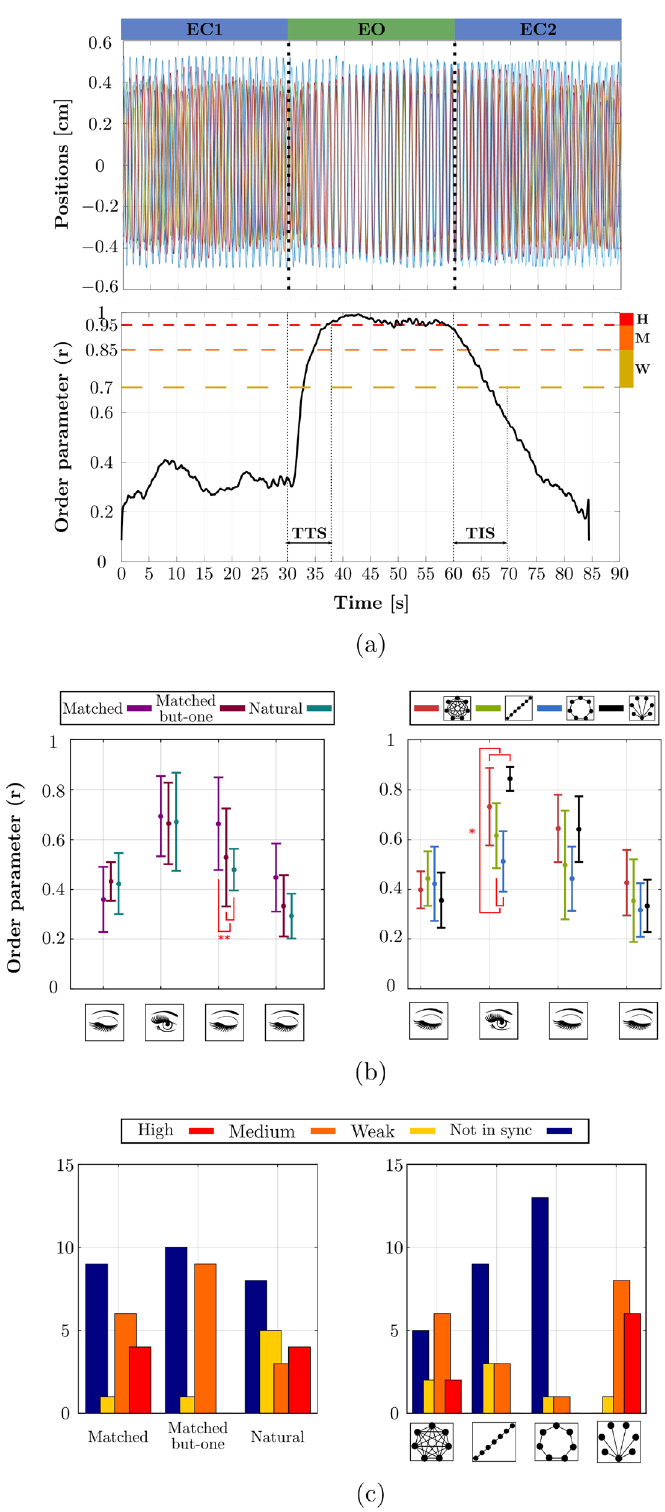
Figure 2. Main results of Experiment 1. ( a ) a representative example of phase synchronization r across periods of absence and presence of visual coupling (Time To Sync TTS = 7.49s and Time In Sync TIS = 9.78s ); ( b ) mean and standard deviation of phase synchronization across homogeneity (left panel) and topology conditions (right panel), n = 240 ; ( c ) distribution of phase synchronization levels (High, Medium, Weak, Not in sync) for Similarity (left panel) and Topology (right panel), n = 60